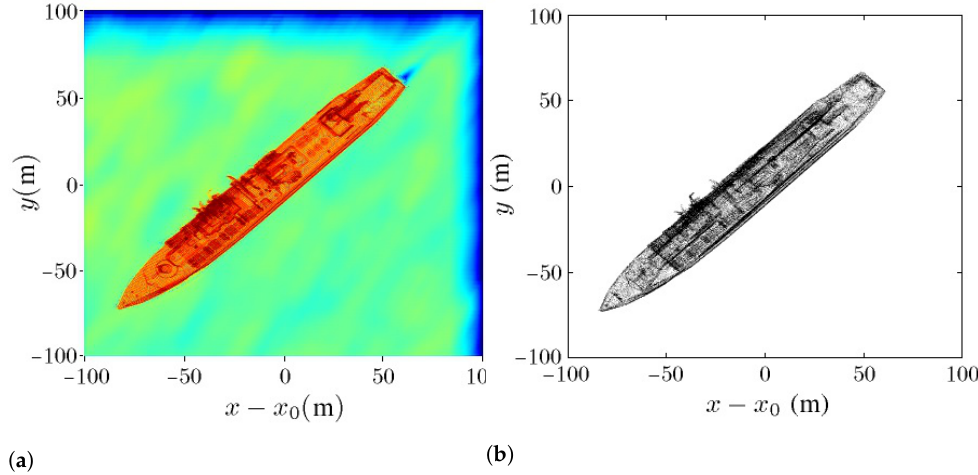
Figure 14. ( a ) Acquired image of Slava-class cruiser, in scale of (40, 90) dB and ( b ) scan image of 3D